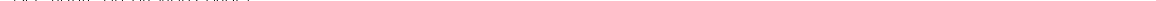
(see fi gure on previous page) Fig. 4 BMI1 regulates MM-M Φ s proliferation. A Left schematic shows the cross-breedings performed to generate BMI1 fl / fl Mx1-Cre mice and inducible Cre-mediated disruption of BMI1 in BMI1 fl / fl Mx1-Cre mice after poly I:C administration. BMI1 fl / fl mice received poly I:C were designated as wild-type (wt) controls. Western blot showed the disruption of BMI1 protein in M Φ s from BMI1-KO mice after poly I:C administration (right panel). B Flow cytometry analyzed the expression of CD206 on the surface of cultured M Φ s and MM-M Φ s from wt control or BMI1-KO mice. MFI of CD206 indicated for each sample. C CFSE cell proliferation assay indicated the knockout of BMI1 in MM-M Φ s impaired their proliferation capacity. D Flow cytometry analyzed BMI1 and Ki67 expression of M Φ s from BM aspirates of 28 MM patients. Left, histograms of BMI1 and Ki67 expression of 2 representative patients with relative lower or higher BMI1 expression. Right panel, the co-expression pattern of BMI1 and Ki67 was showed in dot plots. The correlation was analyzed by linear regression with R square calculated. E The RNA-seq data of murine BM-derived MM-M Φ s from wt and BMI1-KO mice were analyzed with GSEA, showing enrichment of Hallmark E2F targets and G2M checkpoint pathways in wt MM-M Φ s. F Heatmap illustrated the RNA-seq data of CDKN2A, showing signi fi cant upregulation of CDKN2A in BMI1-KO MM-M Φ s. G RT-qPCR showed the mRNA expression of P16 was signi fi cantly higher in BMI1-KO MM-M Φ s, relative to wt MM-M Φ s (left column). Flow cytometry showed the protein level of P16 was